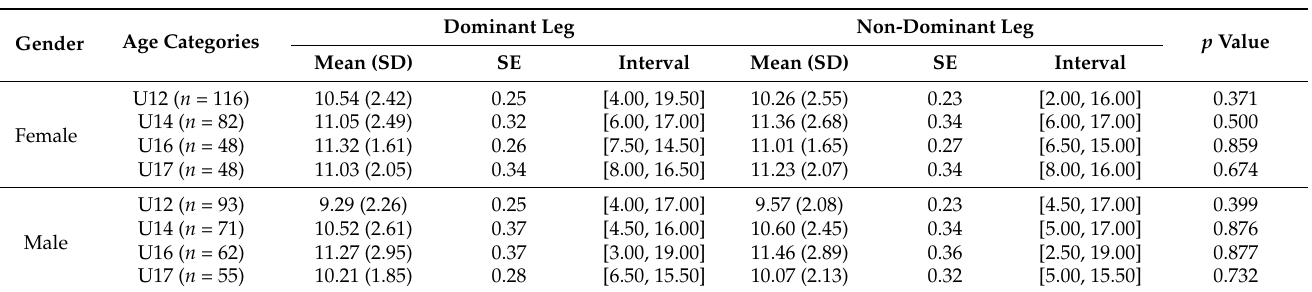
Table 2. Assessment of ankle joint dorsiflexion for between-group comparisons of U12 to U17 basketball players.